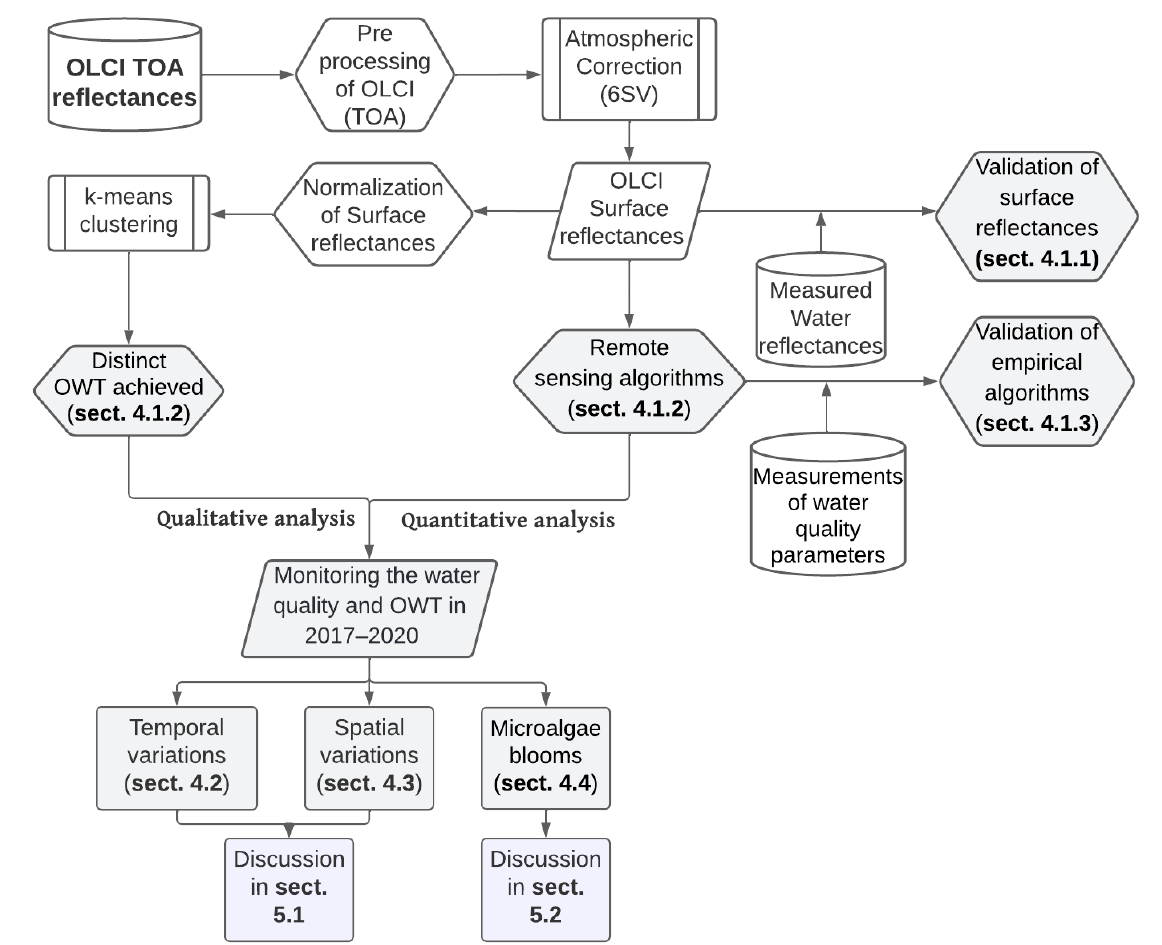
Figure 3. Flowchart showing the methodology using OLCI data and the main results (gray back- ground) obtained in this work.